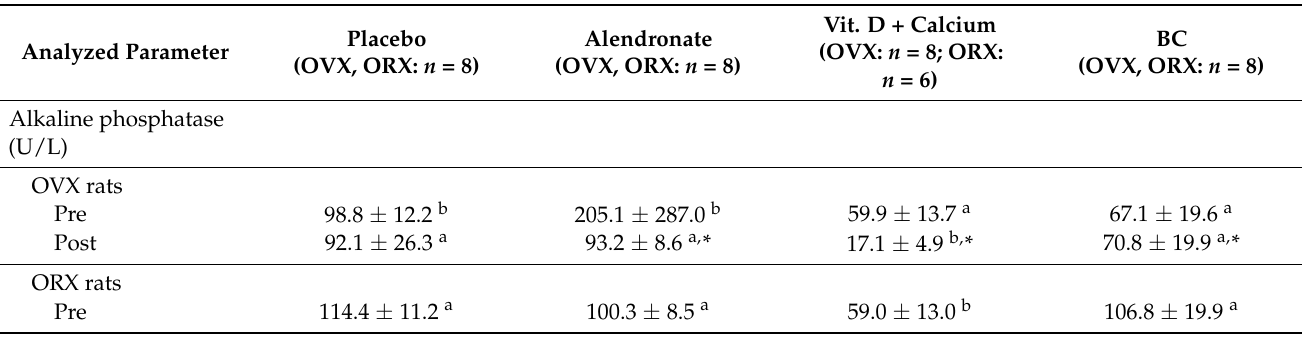
Table 3. Bone biomarkers–evaluation across time (pre-post intervention) of the placebo, alendronate, vitamin D and calcium and BC supplementation groups–OVX and ORX